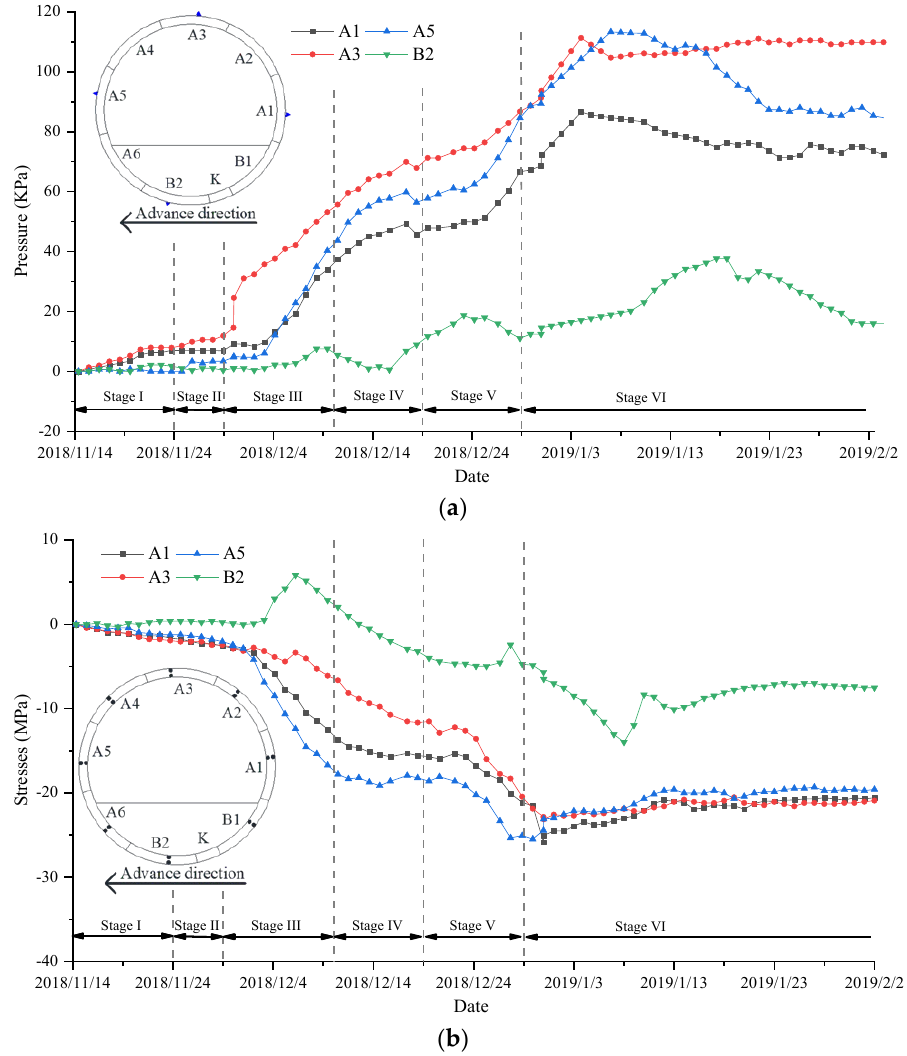
Figure 15. Earth pressure evolution and mechanical responses of the existing large-diameter tunnel: ( a ) earth pressure and ( b ) reinforcement stress.